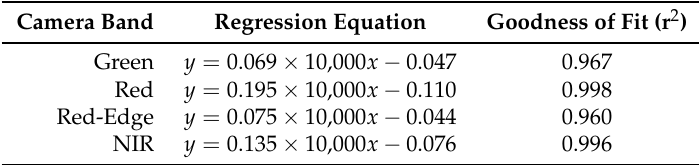
Table 4. Linear equations describing the relationships between image raw digital numbers (DN) and surface reflectance in each multispectral band, and model goodness of fit as described by the adjusted R 2